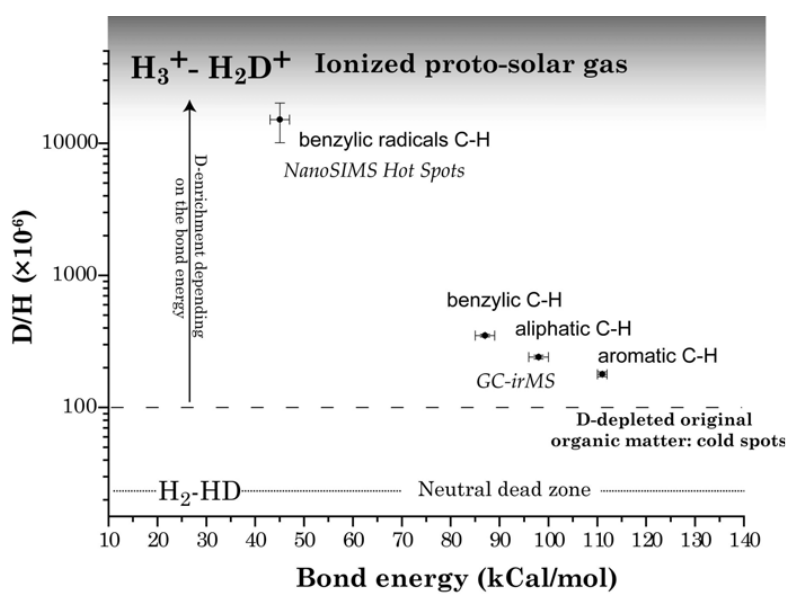
Figure 9. D/H isotopic ratio versus C-H bond energy among different molecular components in Orgueil IOM. The observed trend can be interpreted as the result of an isotopic exchange reaction between D-poor organic solids and ...), most likely taking place in the outer and relatively cold regions of the D-rich gaseous molecules (H 2 D + , HD + 2 protoplanetary